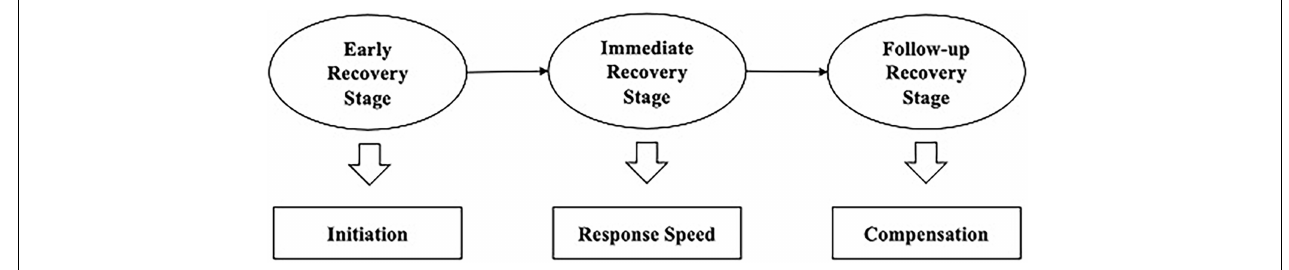
FIGURE 1 | The revised service recovery cycle